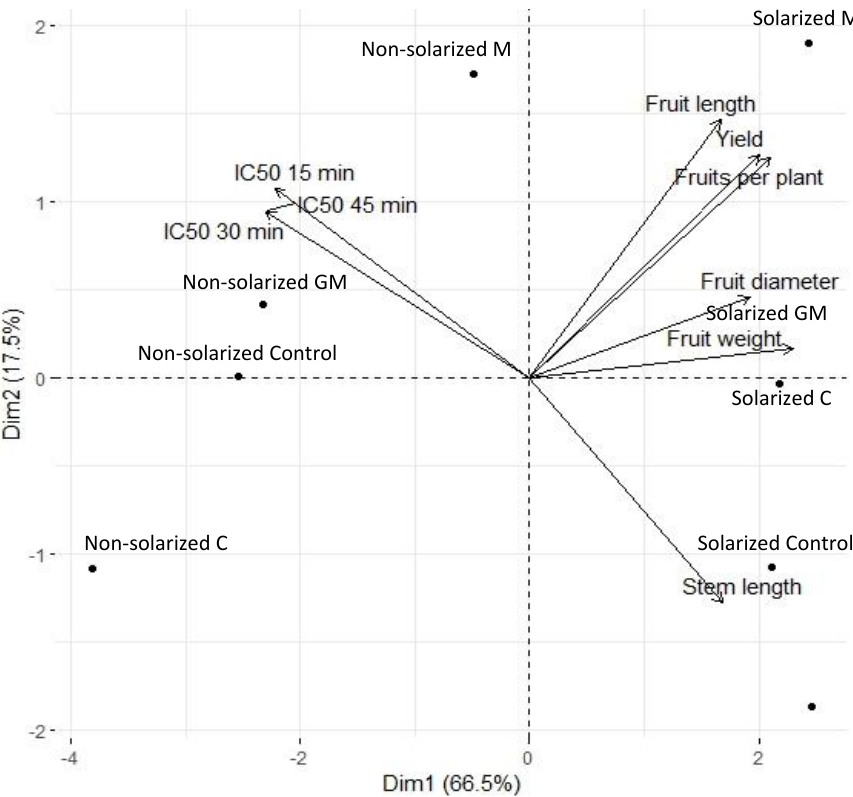
Figure 4. Biplot of loadings and scores in the two-dimensional space.